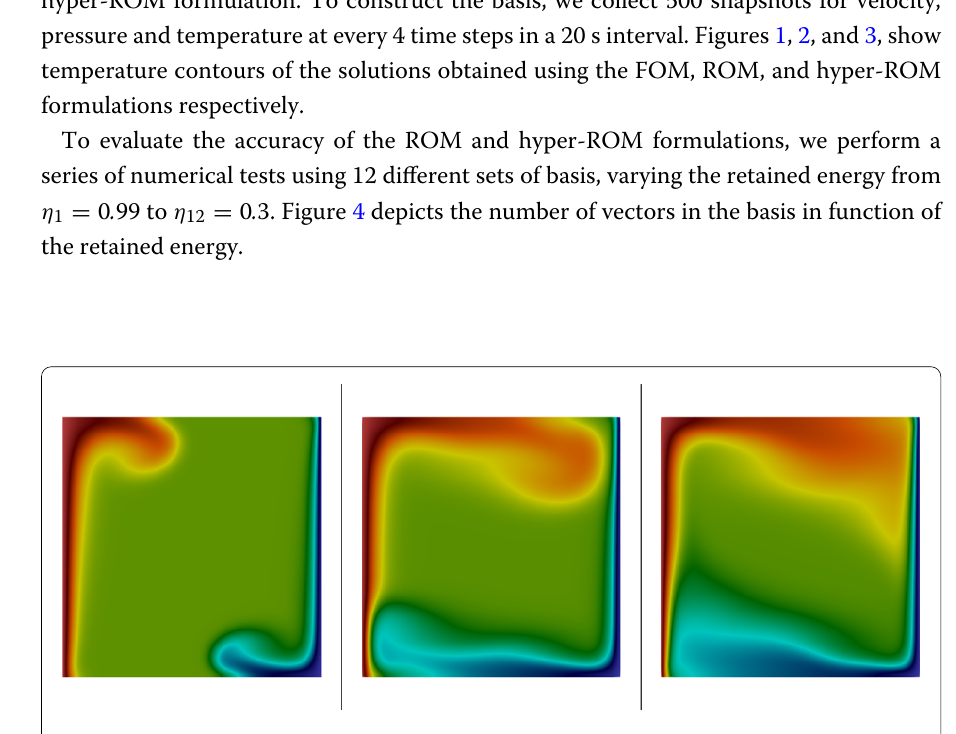
Fig. 1 FOM temperature contours at t = 1, t = 2, and t = 3 s for the 2D differentially heated